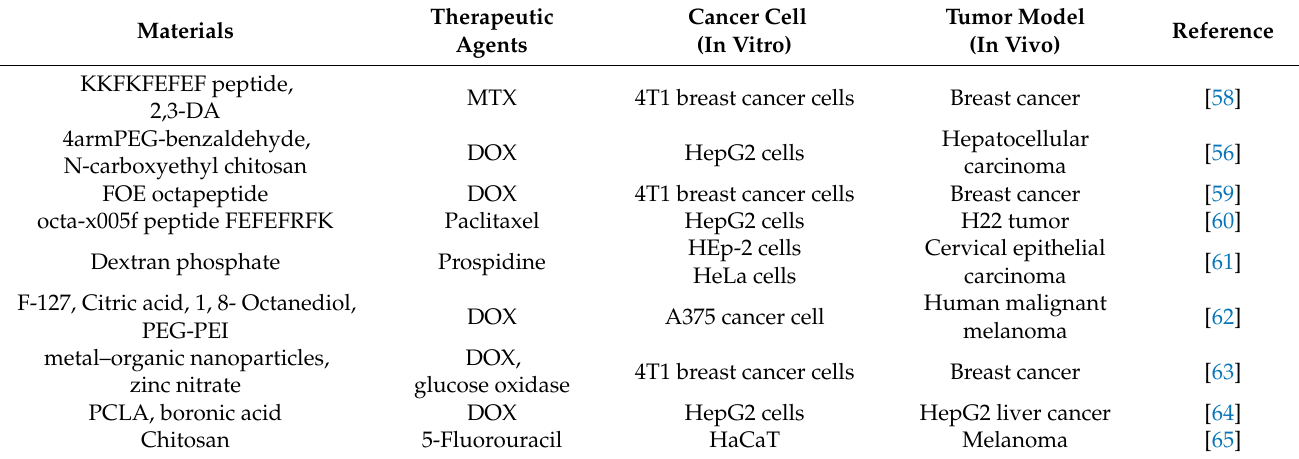
Table 2. Examples of pH-responsive hydrogels recently developed for localized cancer